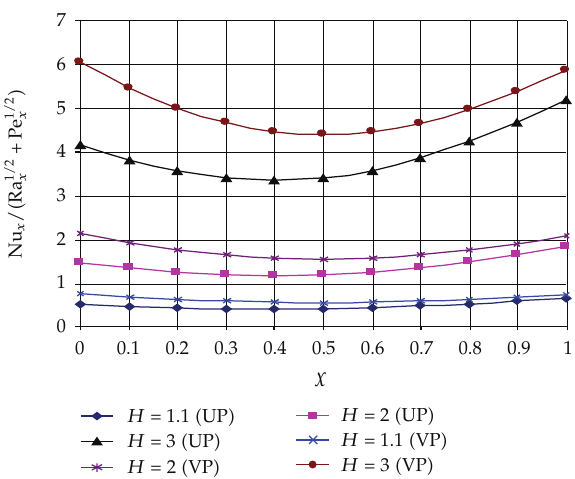
Figure 3: Comparison of values Nu x / (cid:3) Ra 1 / 2 x (cid:9) Pe 1 / 2 x (cid:6) for H and χ with m (cid:8) 0 . 0316 and R d (cid:8) 0 . 3 for both UP and VP cases.